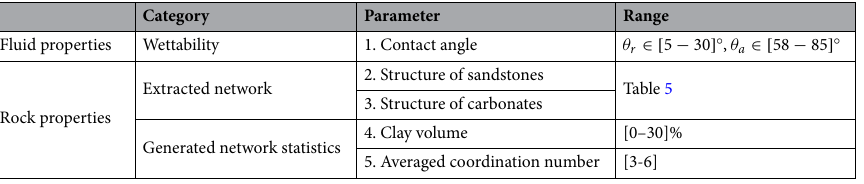
Table 3. Parameters used in the simulations.